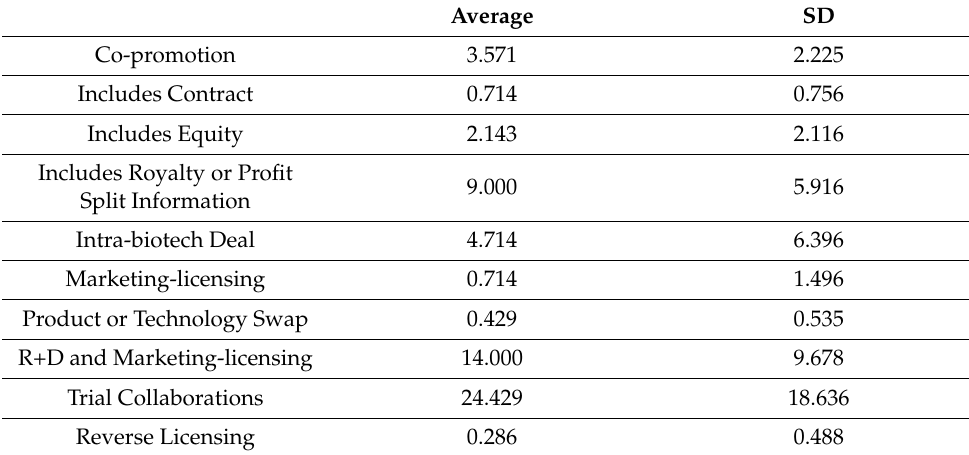
Table 1. The average number of interorganizational transactions for seven immune checkpoint blockade agents in each deal characteristic defined in the